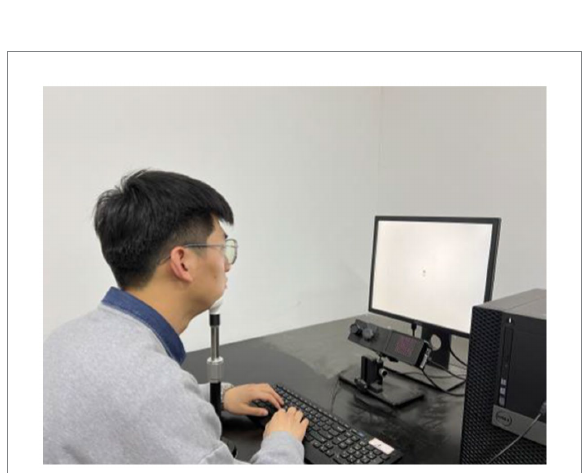
FIGURE 3 Photo of participant participating in the